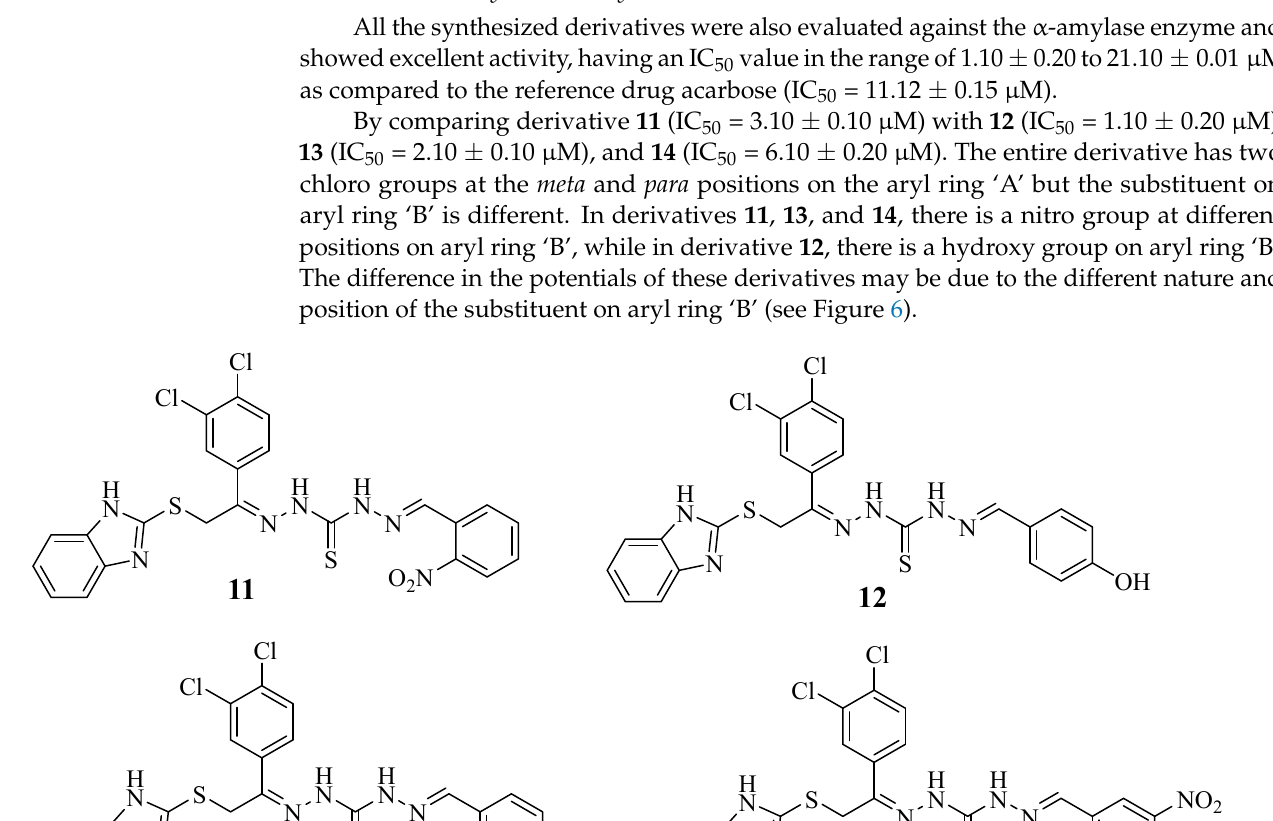
Figure 6. Structure–activity relationship of derivatives 11 , 12 , 13 and 14 .